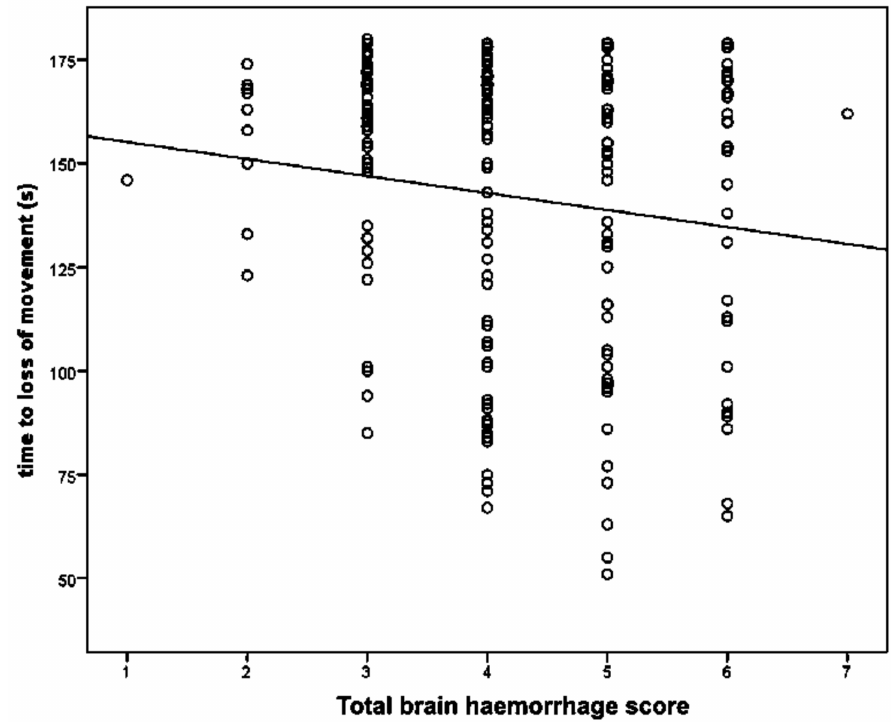
Figure 7. The effect of total brain haemorrhage score on time to loss of movement in lambs,